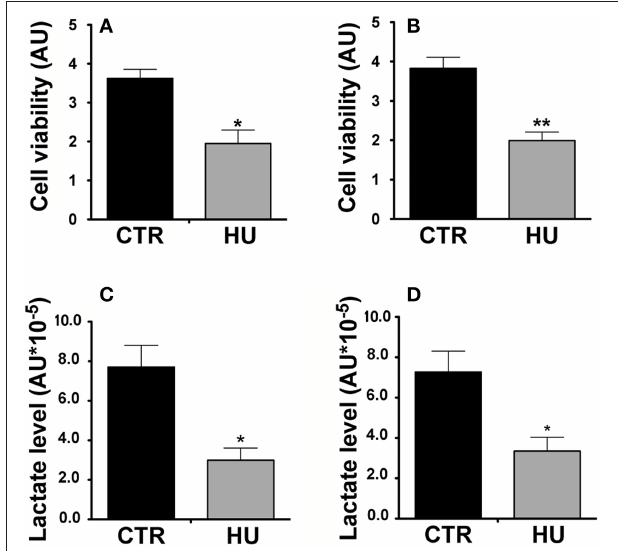
FIGURE 5 | PCR Array analysis of CTR and HU samples. The scatter plot analyzes the normalized expression of all genes on the array between the two groups (CTR and HU) by plotting them against one another and indicating large gene expression alterations. The central line indicates unchanged gene expression whereas the dotted lines show the selected fold regulation threshold. Data points beyond the dotted lines in the upper left and lower right sections exceed the selected fold regulation threshold. The two genes that were observed to be significantly different between CTR and HU are indicated by arrows. (Controls = CTR, n = 7, and Hindlimb Unloading = HU, n = 4).